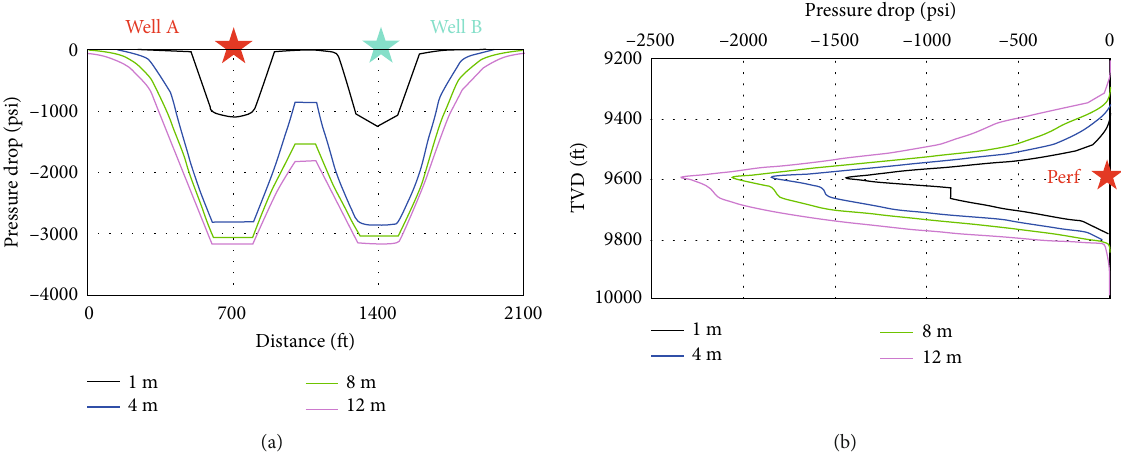
Figure 12: Reservoir pressure pro fi les at di ff erent times: (a) pressure pro fi le in the i -direction and (b) the k -direction from 1 month to 12